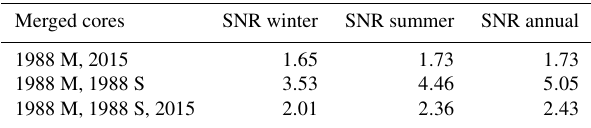
Table 3. Mean signal-to-noise variance ratios calculated for the summer, winter and annually averaged data using two and three cores in the period